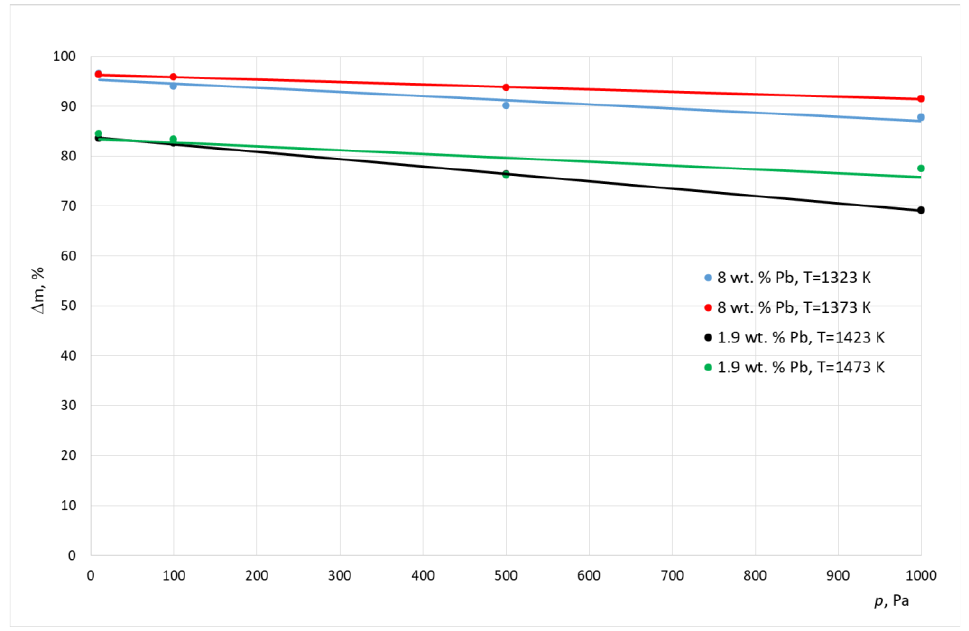
Figure 3. Relative mass loss of lead during smelting realized inside CCF, with different working pressures.